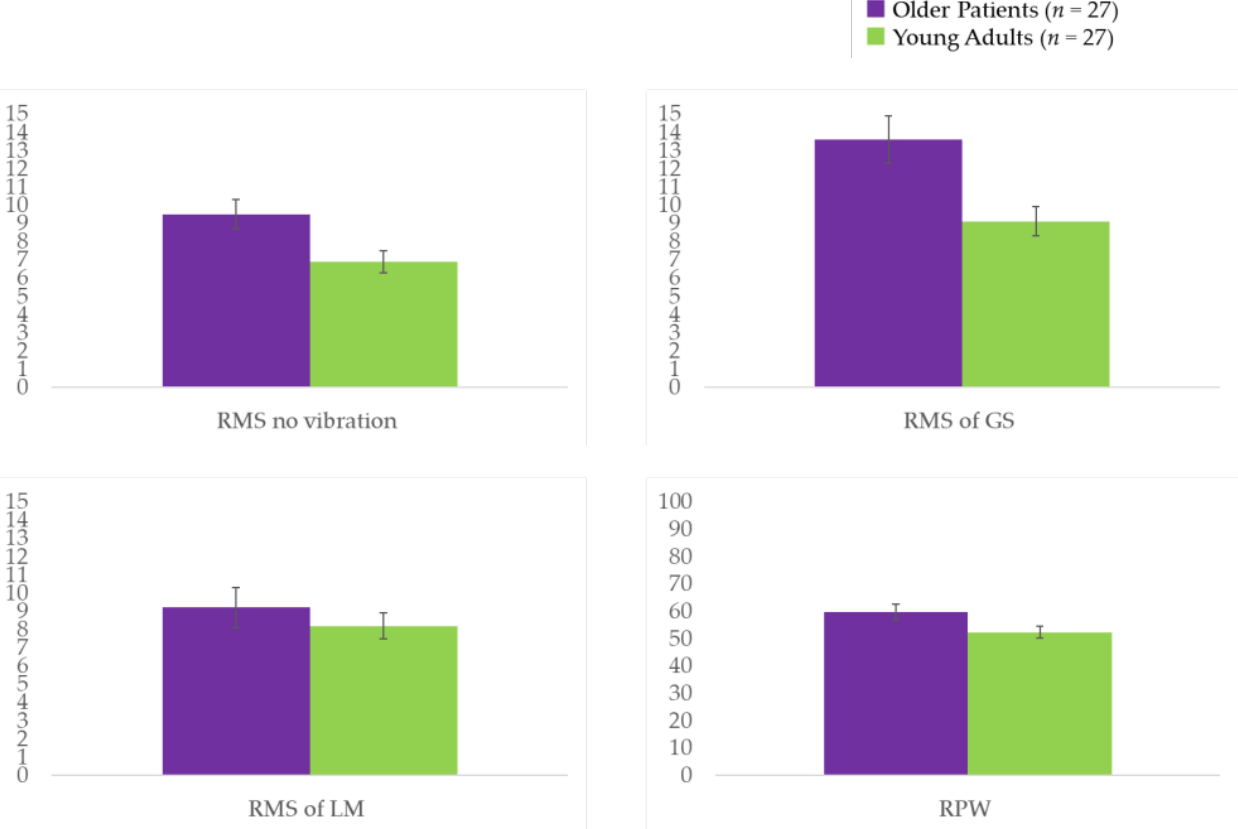
Figure 2. RMS values of the COP displacement for the trials on the balance board. COP: center of pressure; GS: gastrocnemius and soleus muscles; LM: lumbar multifidus; RMS: root mean square; RPW: relative proprioceptive weighting ratio. A unit of RMS = mm; a unit of RPW = %.